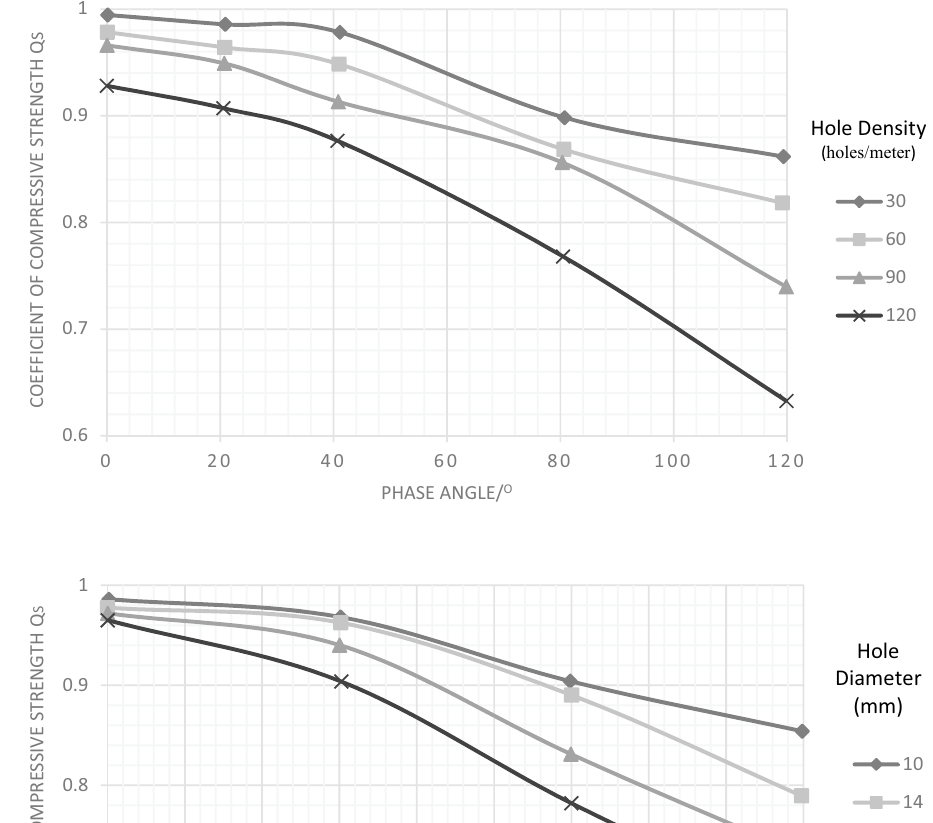
Fig. 9 Influence of differ- ent hole densities and hole diameters on collapse resistance strength factor